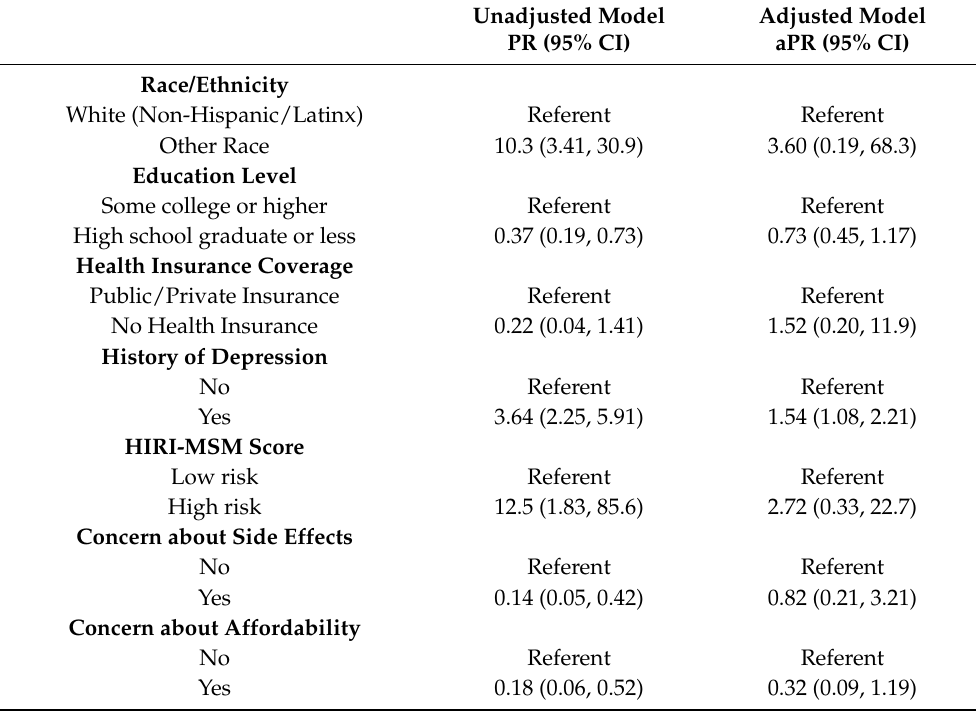
Table 4. Multivariable analyses of correlates of lifetime PrEP use among a community-based sample of cisgender men and transgender women who have sex with men residing on Long Island,